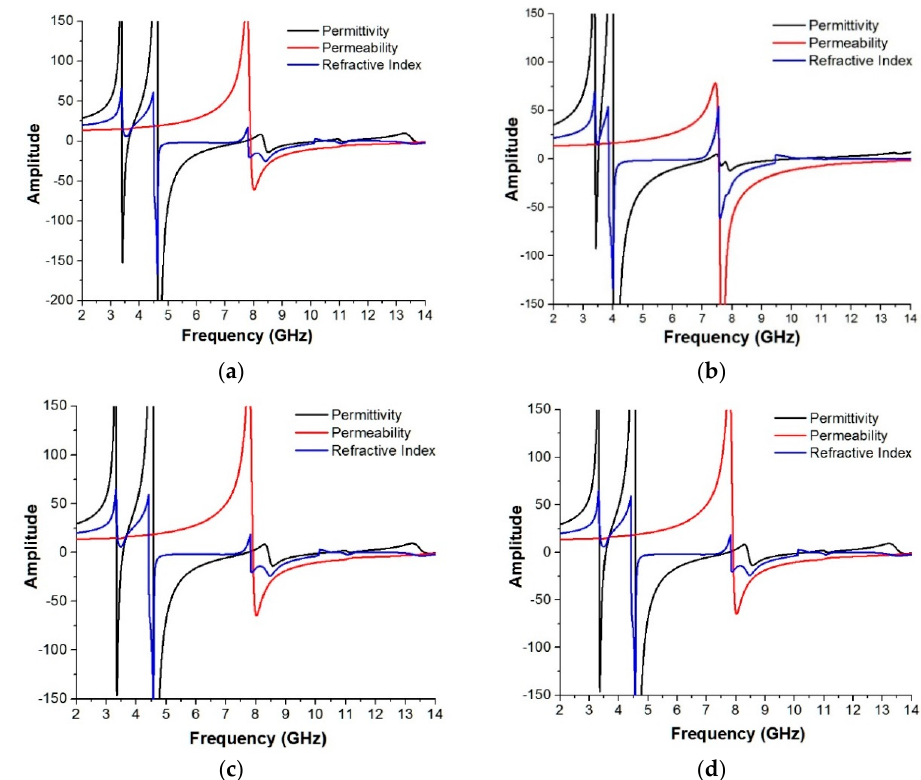
Figure 10. Amplitude of the permittivity, permeability and refractive index at: ( a ) 0°, ( b ) 90°, ( c ) 180°, ( d ) 270° rotation of the 1 × 2 array structure. Table 3. Real values of ε , μ and n at 9.20 GHz.